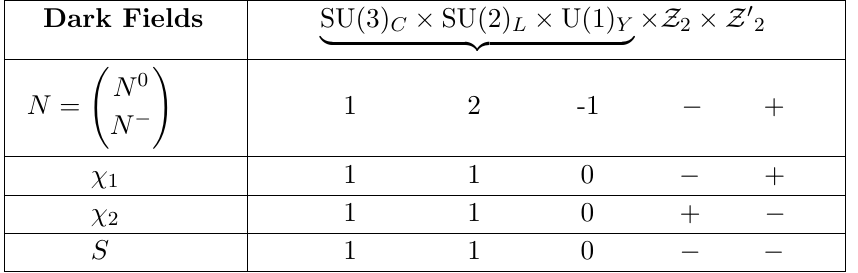
SU(3) C G (cid:17) (cid:2)